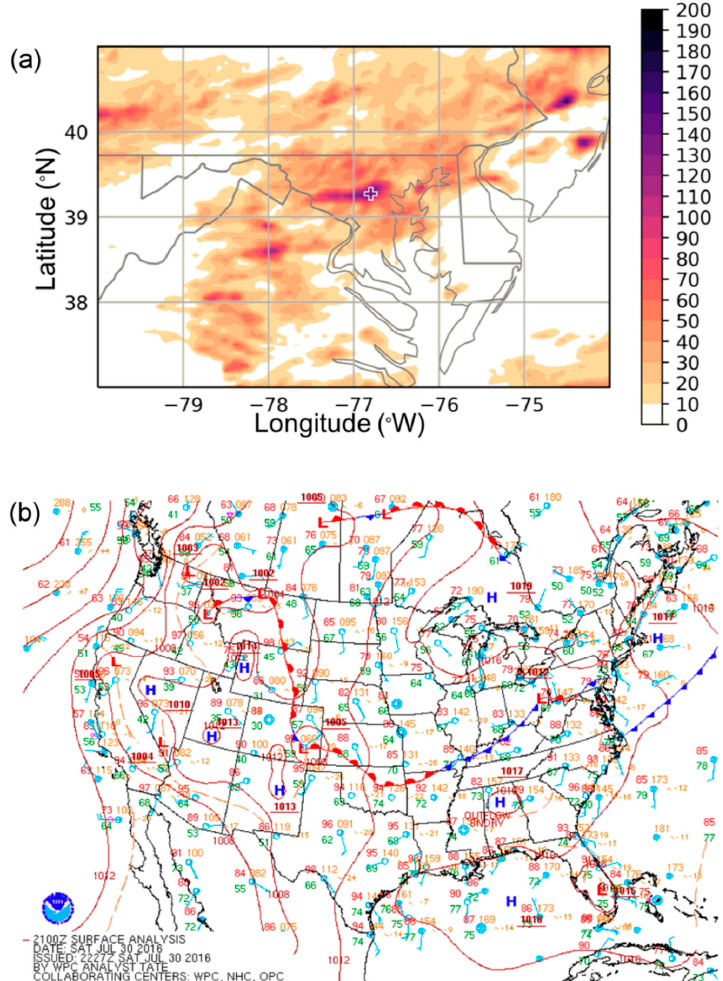
Figure 1. Meteorological overview of the July 2016 flood. ( a ) Stage IV estimated rainfall totals for the 24 h period ending 12 UTC 31 July 2016 and ( b ) National Weather Service (NWS) Weather Prediction Center surface maps for the continental United States valid at 21 UTC 30 July 2016. In the top panel, the location of Ellicott City is indicated by a plus sign near the center of the domain at 39.27°N, 76.80°W.